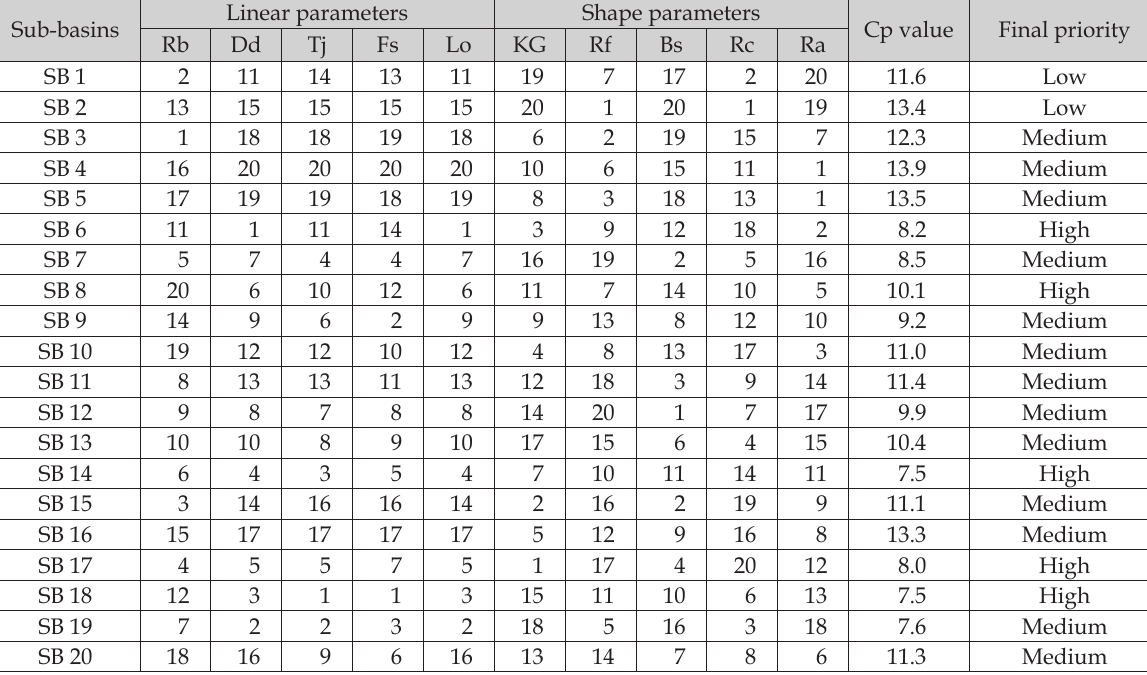
Table 8. Results of the prioritisation of the morphometric analysis of the Soungrougrou sub-catchments.